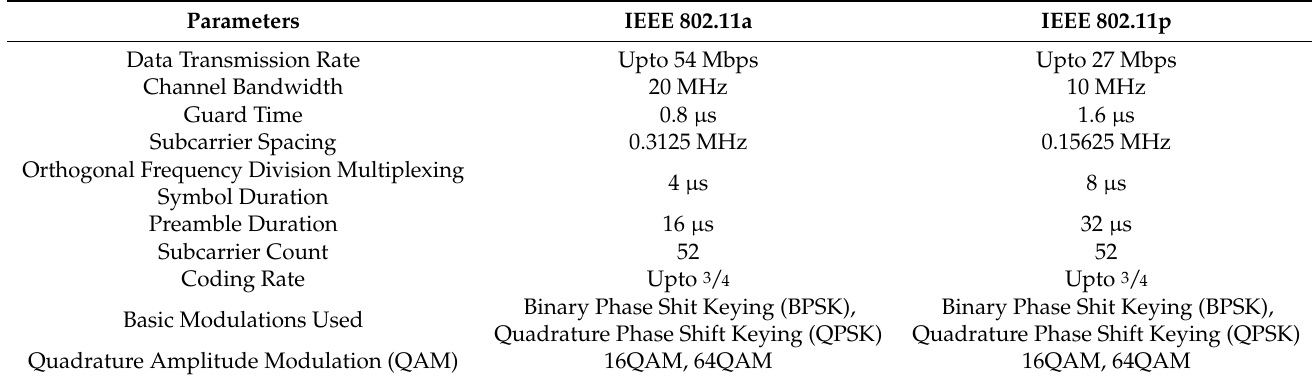
Table 5. Parameter Specifications of IEEE 802.11a and IEEE